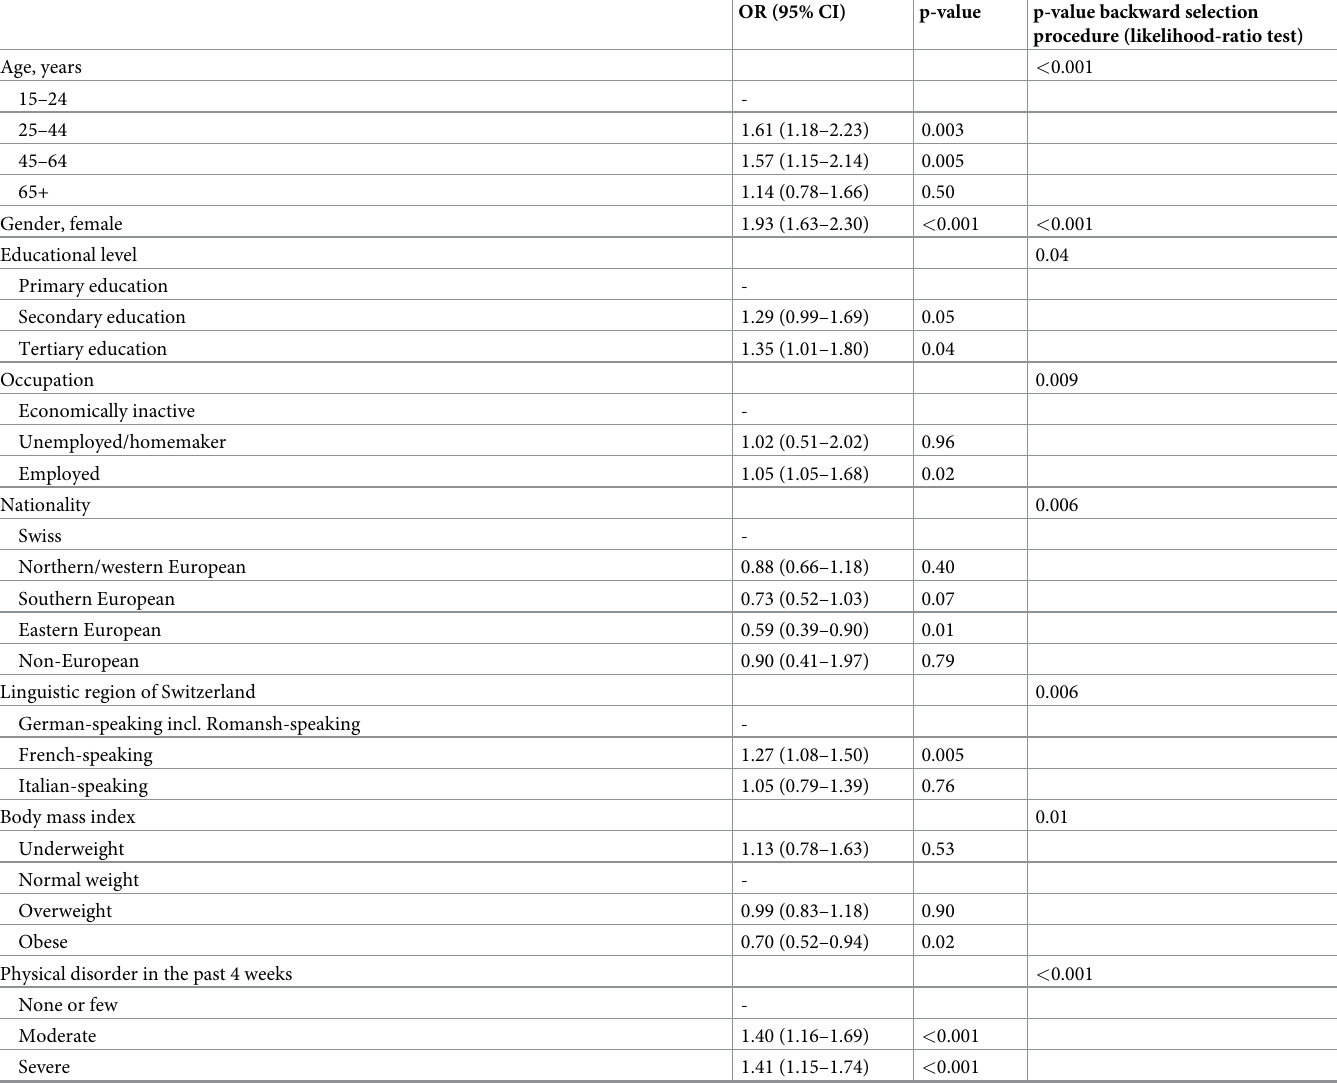
Table 4. Determinants of traditional Chinese medicine use including acupuncture using multivariate logistic